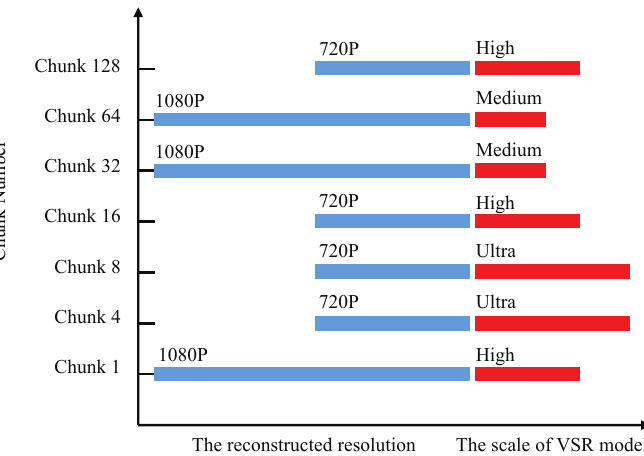
Figure 6. The model level and the number of ResNet block for different chunks. It can be found that our proposed algorithm actually chooses different model scales adapt to the time-varying computing